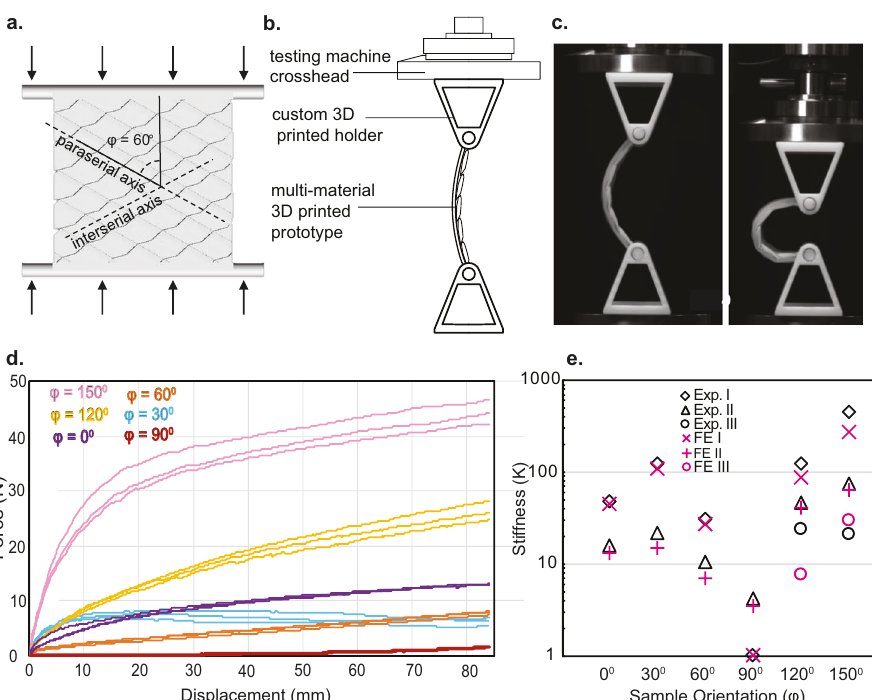
Fig. 4 Anisotropic bending stiffness of the fl exible composite prototypes. a Rendered front view of the prototype designed for bending with rigid rods at the top and bottom and with the paraserial axis oriented at an angle ( φ ) = 60° away from the loading direction. b Schematic drawing of the sample holder. c Side view of the φ = 60° sample loaded in bending at various vertical displacements ( d ): d = 20 mm (left) and d = 80 mm (right). d Force – displacement curves for prototypes with φ = 0°, 30°, 60°, 90°, 120°, and 150°. e Normalized stiffness ( K ) of each phase of each prototype ’ s loading curve (experiments and fi nite element simulations). Error bars represent standard deviation with N = 3 samples per prototype